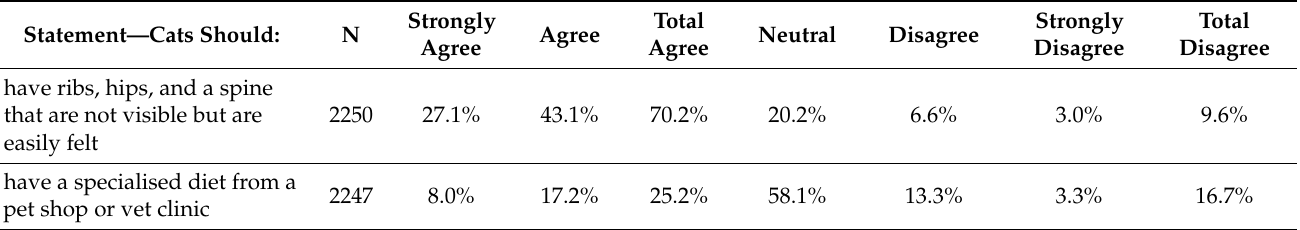
Table 3. Percentage of 2019 New Zealand Pet Survey respondents are selecting each level of agreement for the statements regarding appropriate body conditions and specialised pet